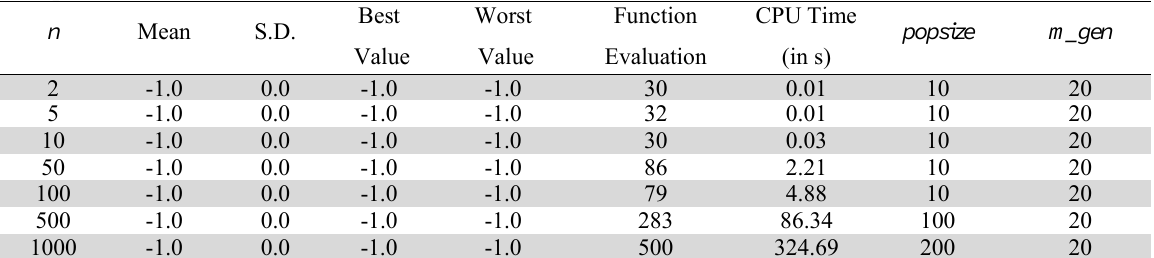
Computational Results of Problem -3